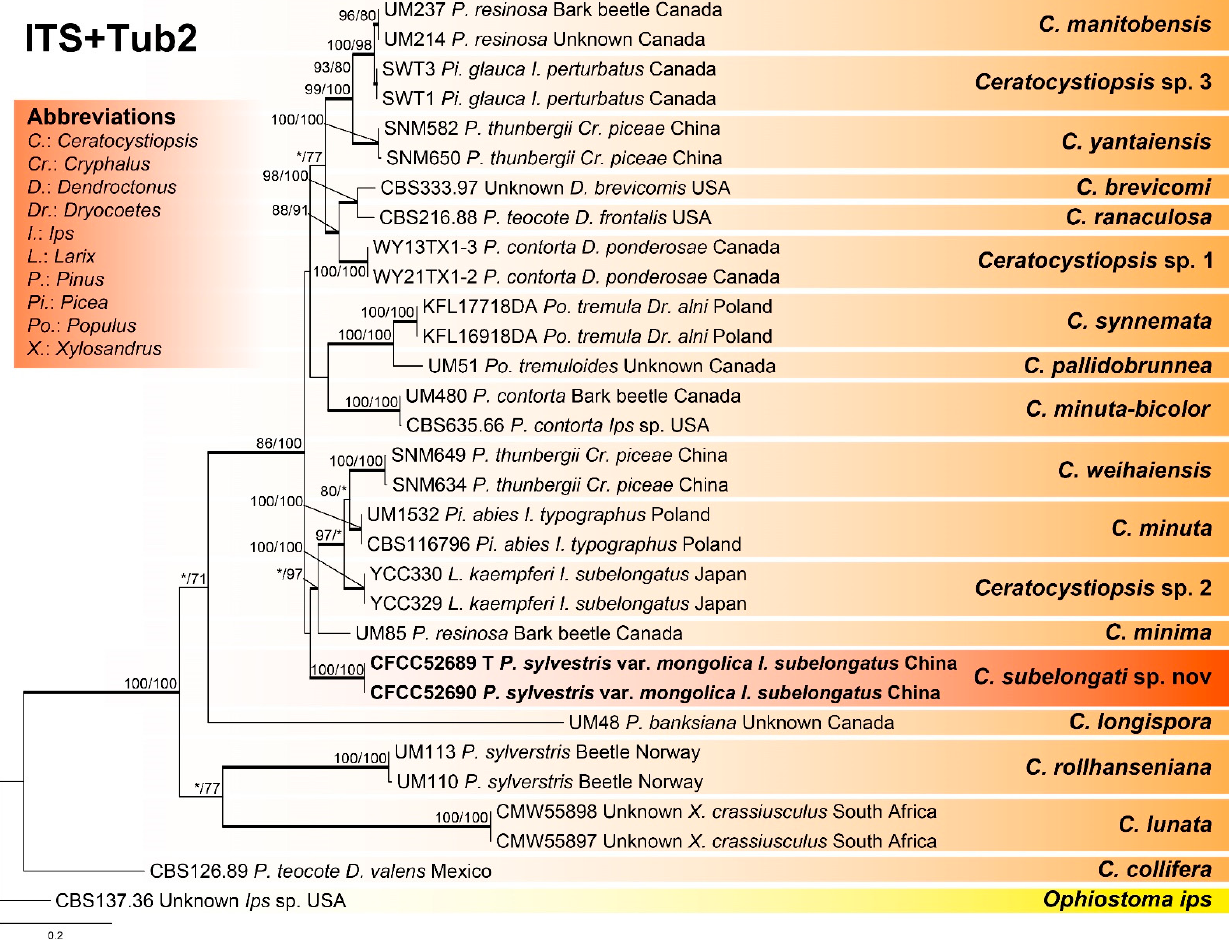
Figure 1. Phylogram of Ceratocystiopsis spp. based on combined (ITS + Tub2) sequence data. Bold branches indicate posterior probability values ≥ 0.9. Bootstrap values of ML/MP ≥ 70% are recorded at nodes. T = ex-type isolates. * Bootstrap values <